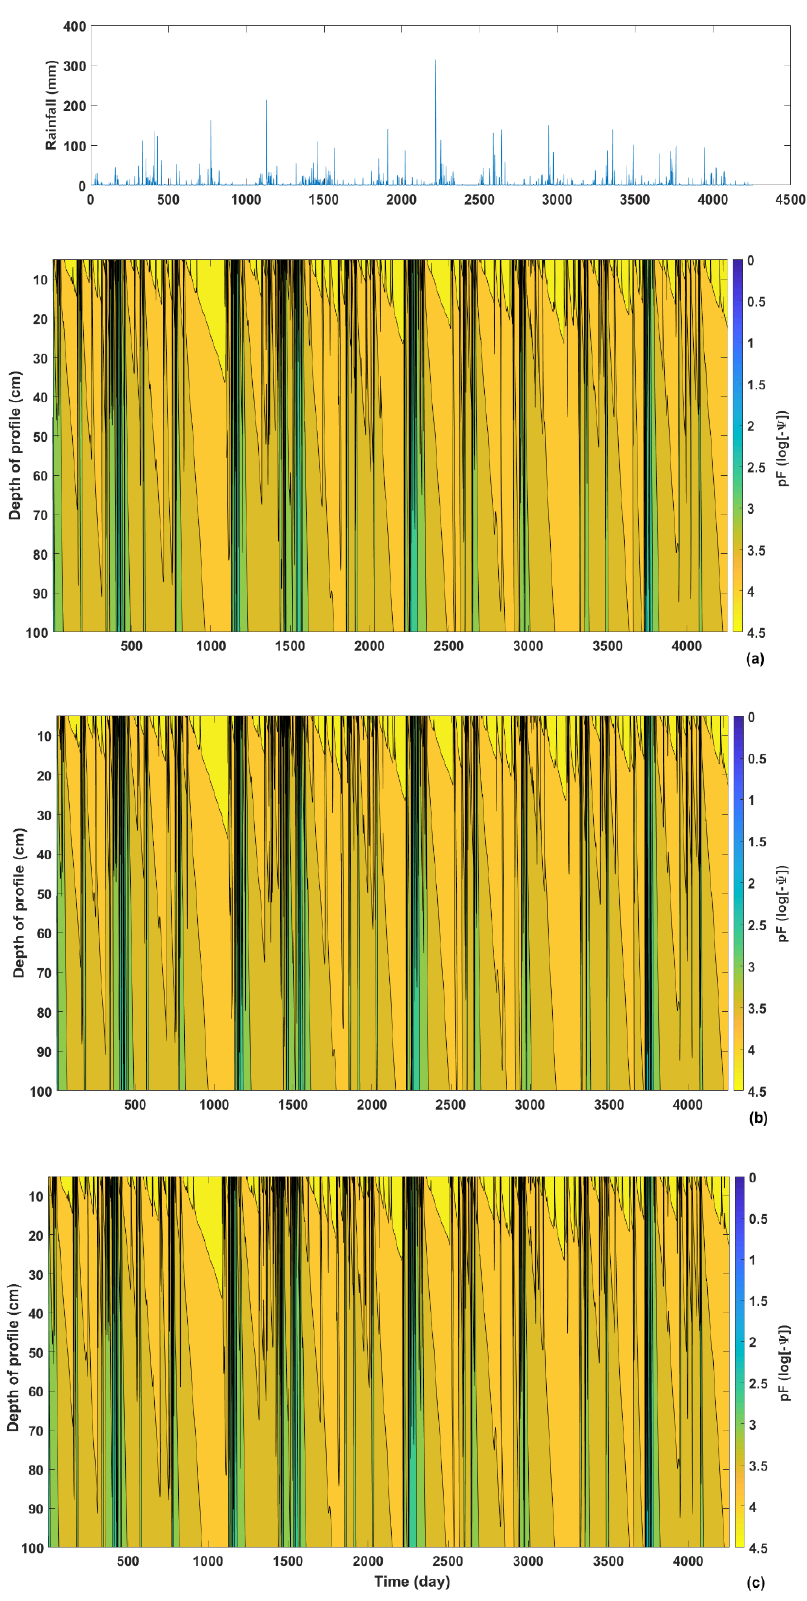
Figure 4. The simulated water potentials of the bauxite residue in a storage facility with initial water potentials of ( a ) −1 kPa, ( b ) −2 kPa and ( c ) −10 kPa. Ψ: water potential (hPa).